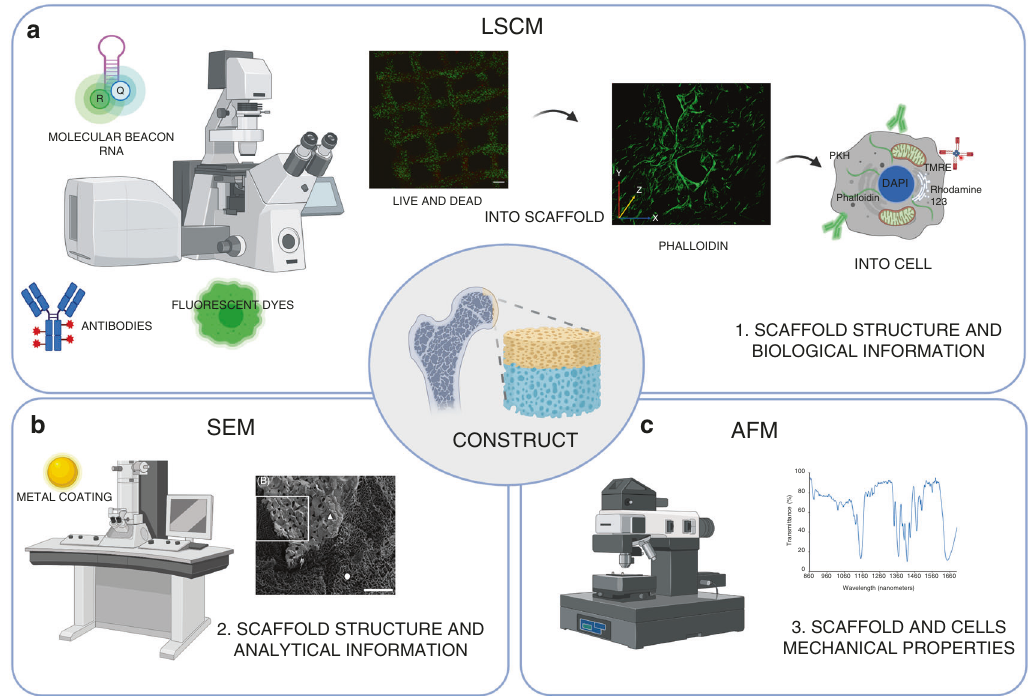
Fig. 3 Summary of microscopy techniques for qualitative and quantitative assessment of cells, scaffolds and tissue engineered constructs. a With laser scanning confocal microscopy (LSCM), it is possible to analyze the expression of speci fi c proteins and nucleic acids and to assess the biological responses and morphological organization of cells using fl uorescent dyes. b With scanning electron microscopy (SEM), it is possible to gather high-resolution structural and analytical information about tissues and constructs. c Atomic force microscopy (AFM) allows us to analyze the surface and mechanical properties of